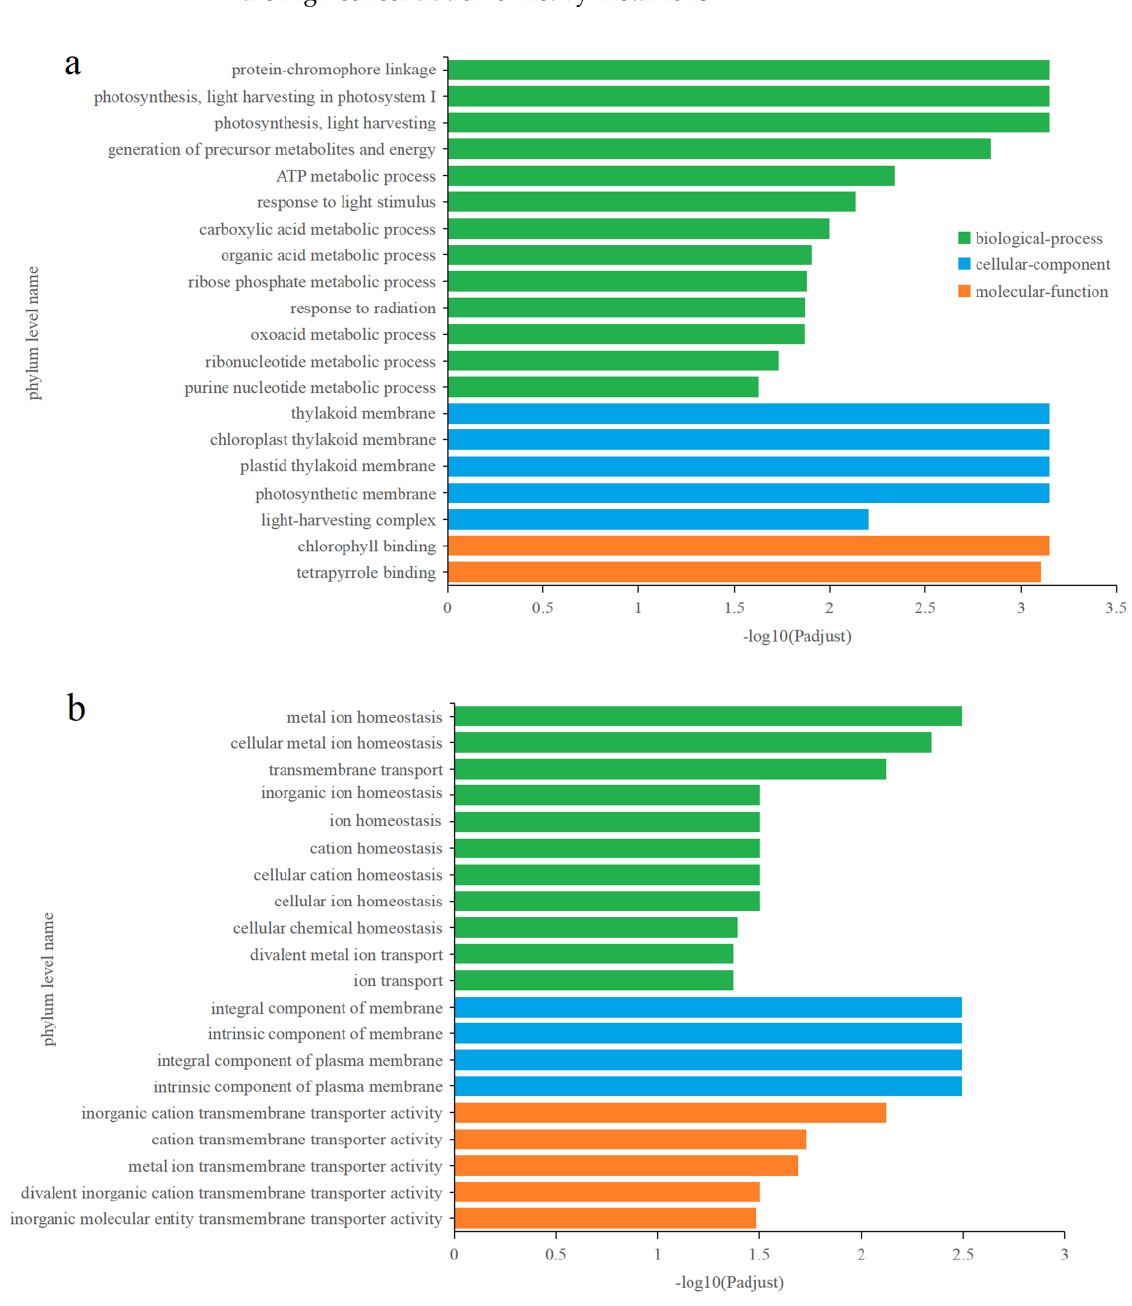
Figure 6. Gene Ontology (GO) enrichment analysis of differentially expressed genes (DEGs) in P. tricornutum under Cu 2+ treatment. ( a ) Upregulated genes in PTCu/PTC. ( b ) Downregulated genes in PTCu/PTC.